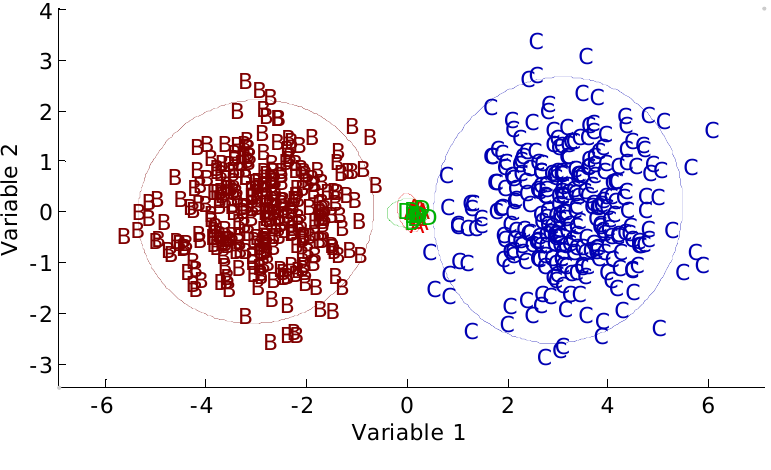
Figure 11. Two-variable plot of the synthetic imbalanced data set. A (red), B, and C